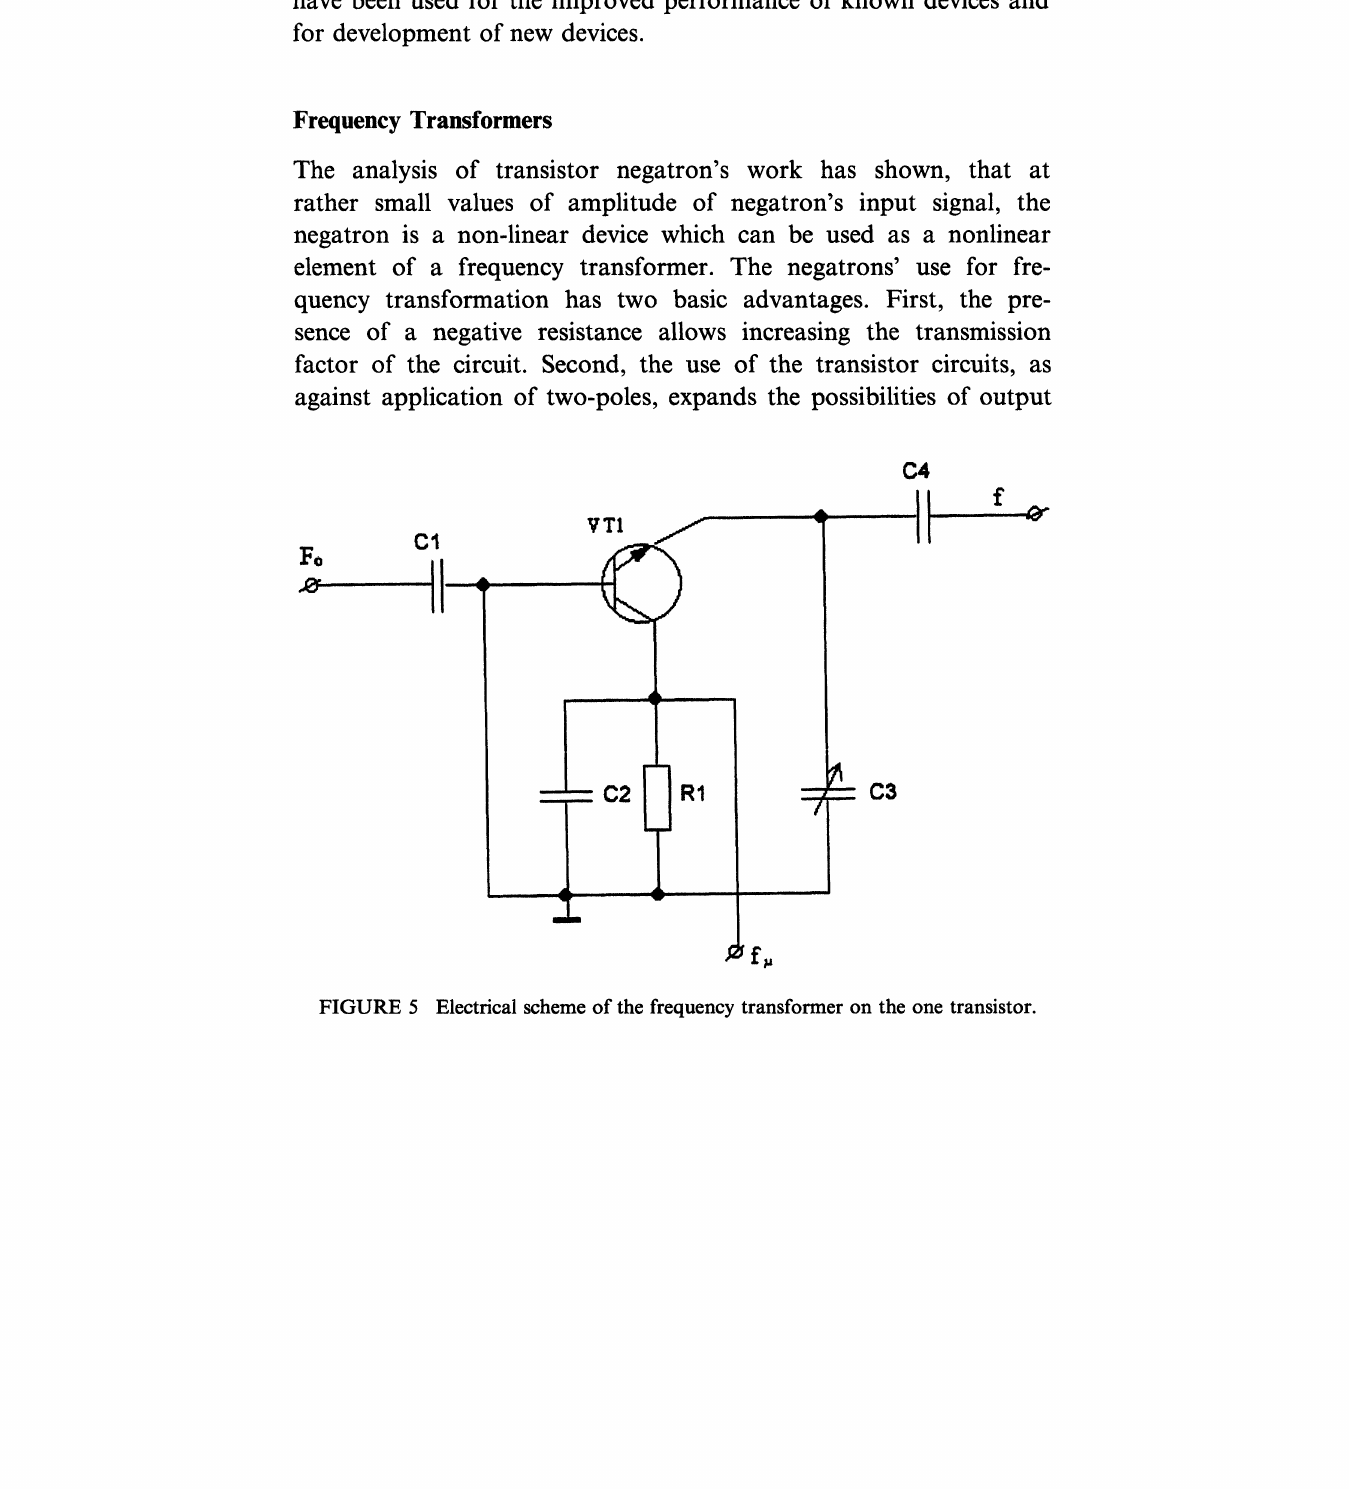
FIGURE 5 Electrical scheme of the frequency transformer on the one